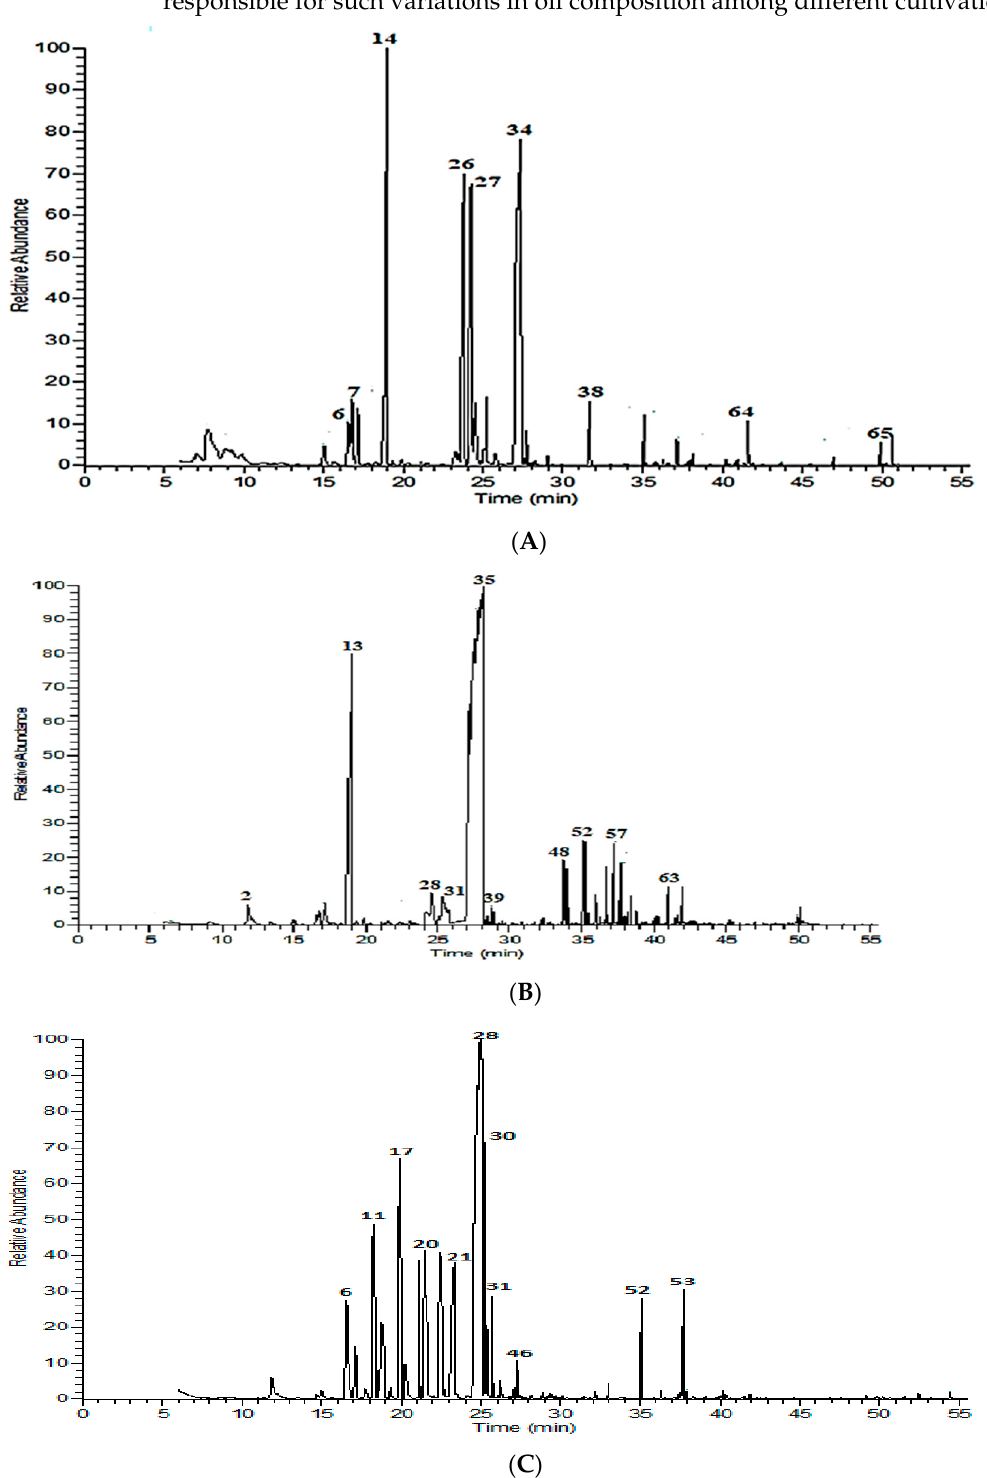
Figure 1. Volatile chromatograms for Madinah, Saudi Arabia ( A ) M. longifolia , ( B ) M. spicata , and ( C ) O. majorana .